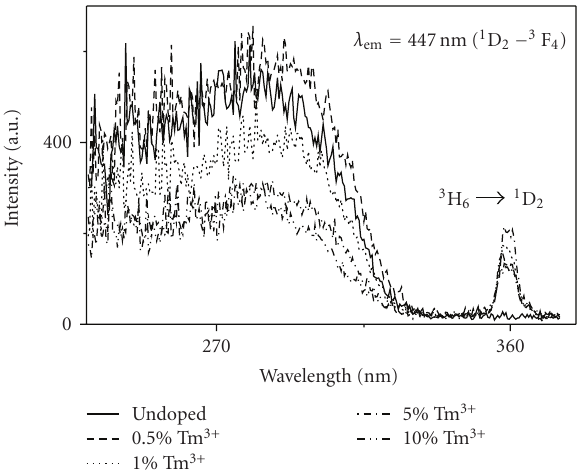
Figure 7: Room temperature excitation spectra of LiIn 1 − x Tm x (WO 4 ) 2 ( x = 0, 0.5, 1, 5, and 10 at.%), monitoring 447 nm emission wavelength ( 1 D 2 → 3 F 4 transition).